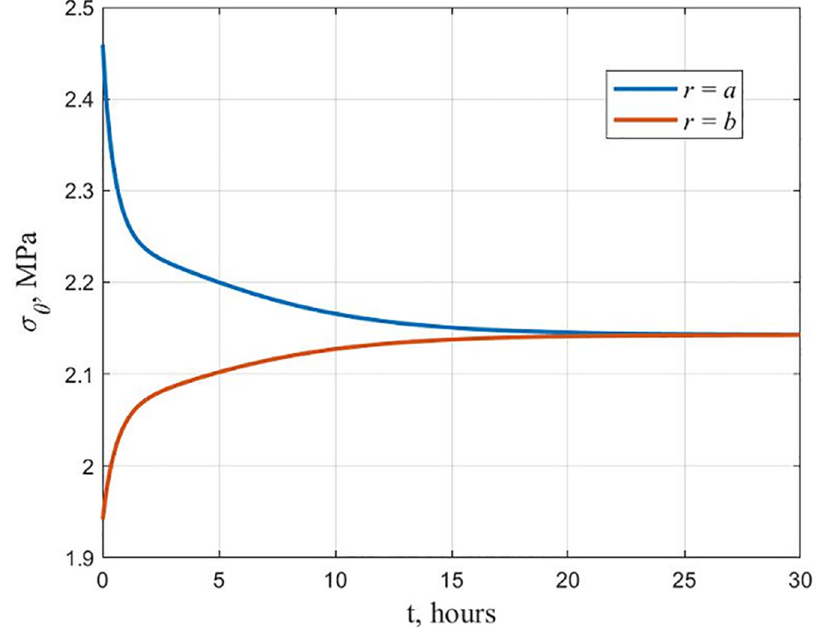
Figure 10. Variation in time of stresses σ θ for an equally stressed cylinder at the end of the creep process.